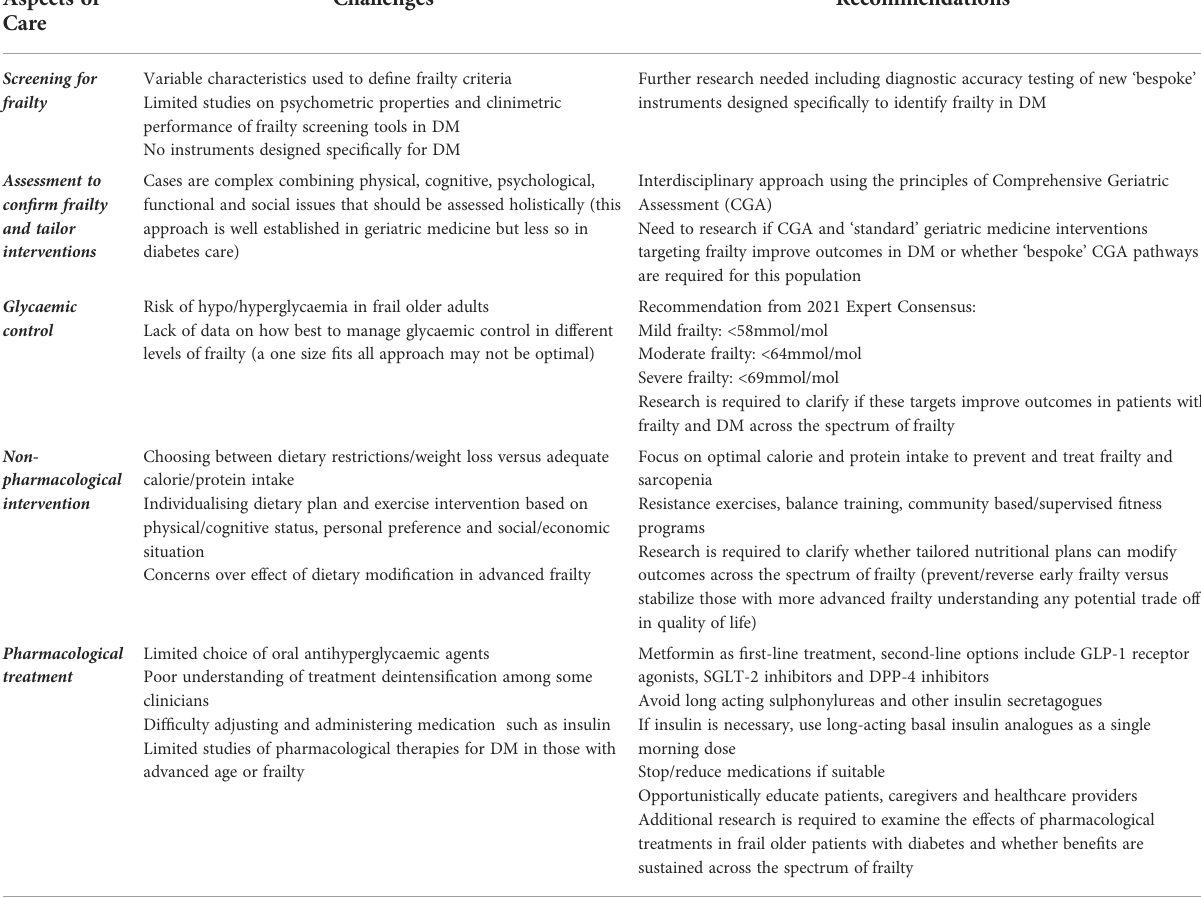
TABLE 1 Overview of key challenges and recommendations on the management of diabetes mellitus (DM) in frail older adults. Aspects of